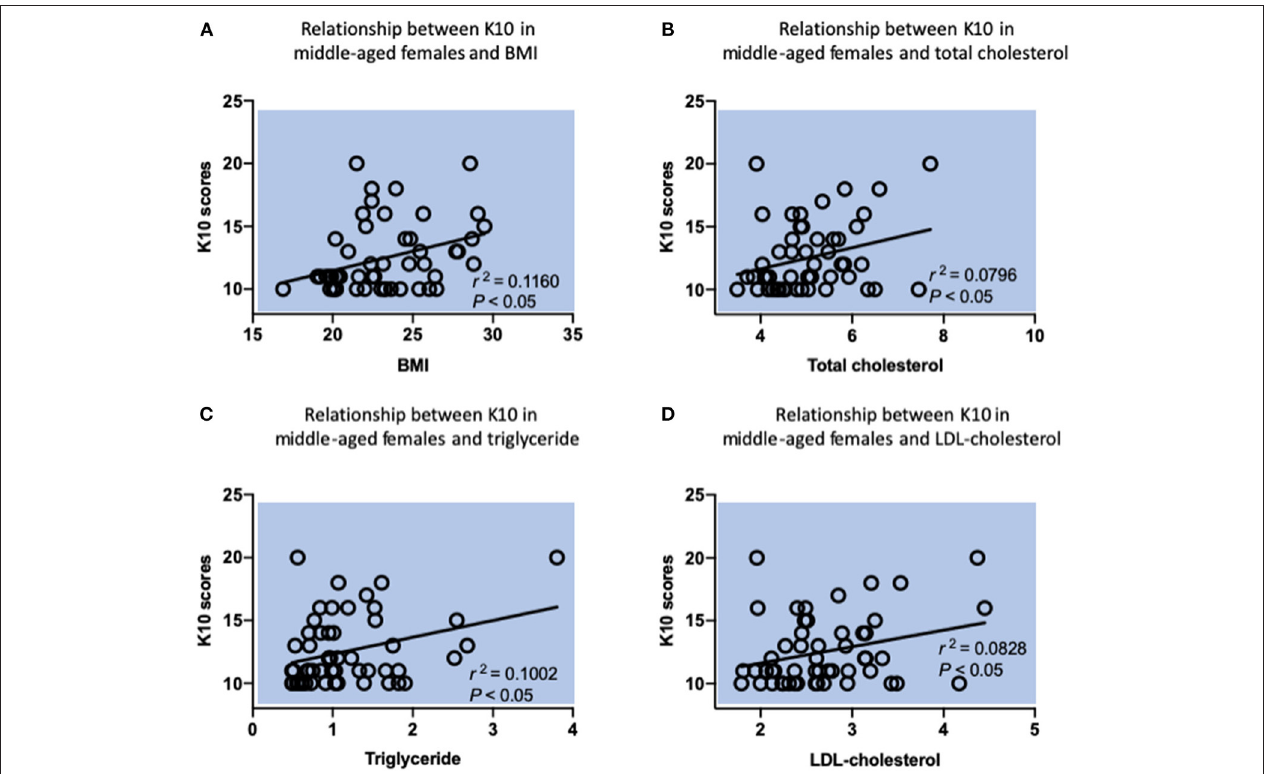
FIGURE 1 | Relationship between K10 scores and metabolic parameters in middle-aged females by Pearson correlation analysis. (A) A positive relationship between K10 scores and BMI. r 2 = 0.116, P = 0.0135. (B) A positive relationship between K10 scores and total cholesterol. r 2 = 0.0796, P = 0.0427. (C) A positive relationship between K10 scores and triglyceride. r 2 = 0.1002, P = 0.0222. (D) A positive relationship between K10 scores and LDL-cholesterol. r 2 = 0.0828, P = 0.0385. n = 52 individuals for this